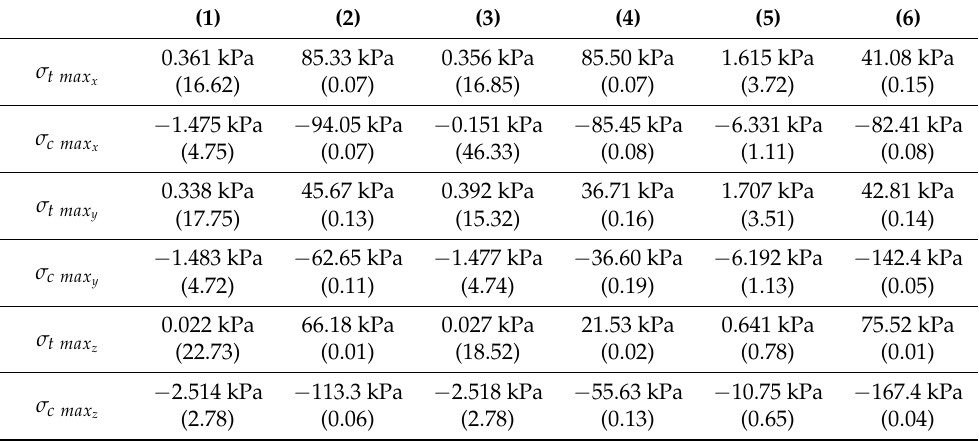
Table 3. Maximum tensile and compression stresses σ t , c max case. The safety factor 𝑆 is written in brackets.